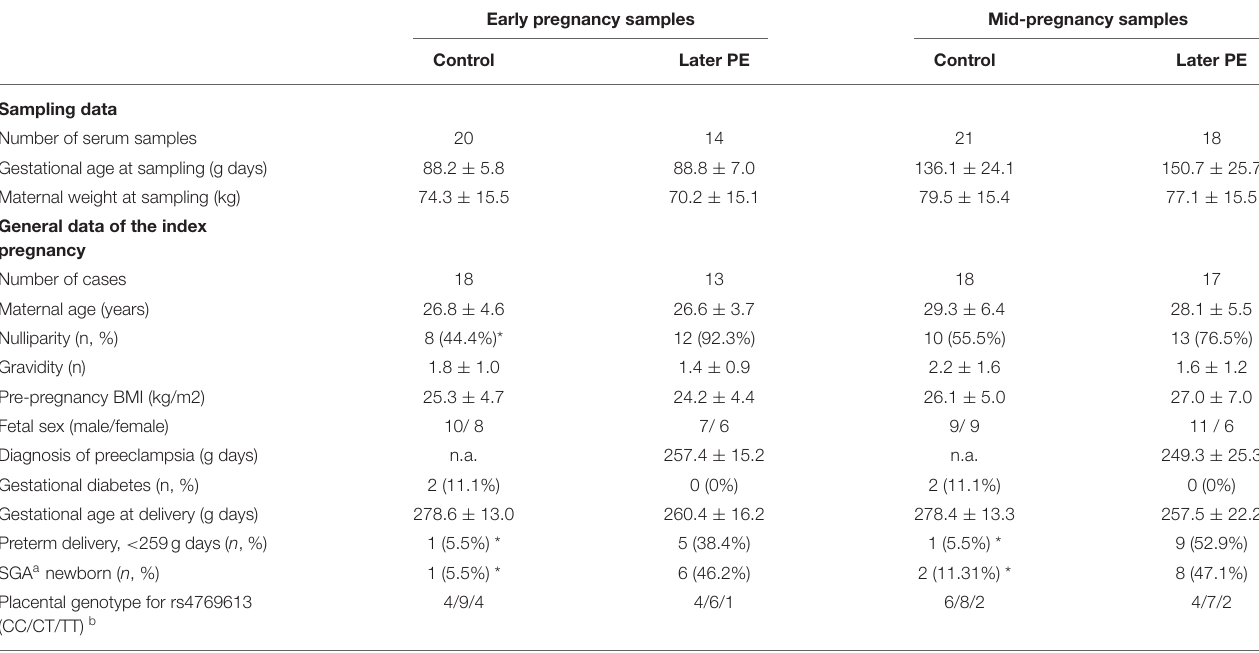
TABLE 1 | Maternal and pregnancy characteristics of the cases involved in PE prediction